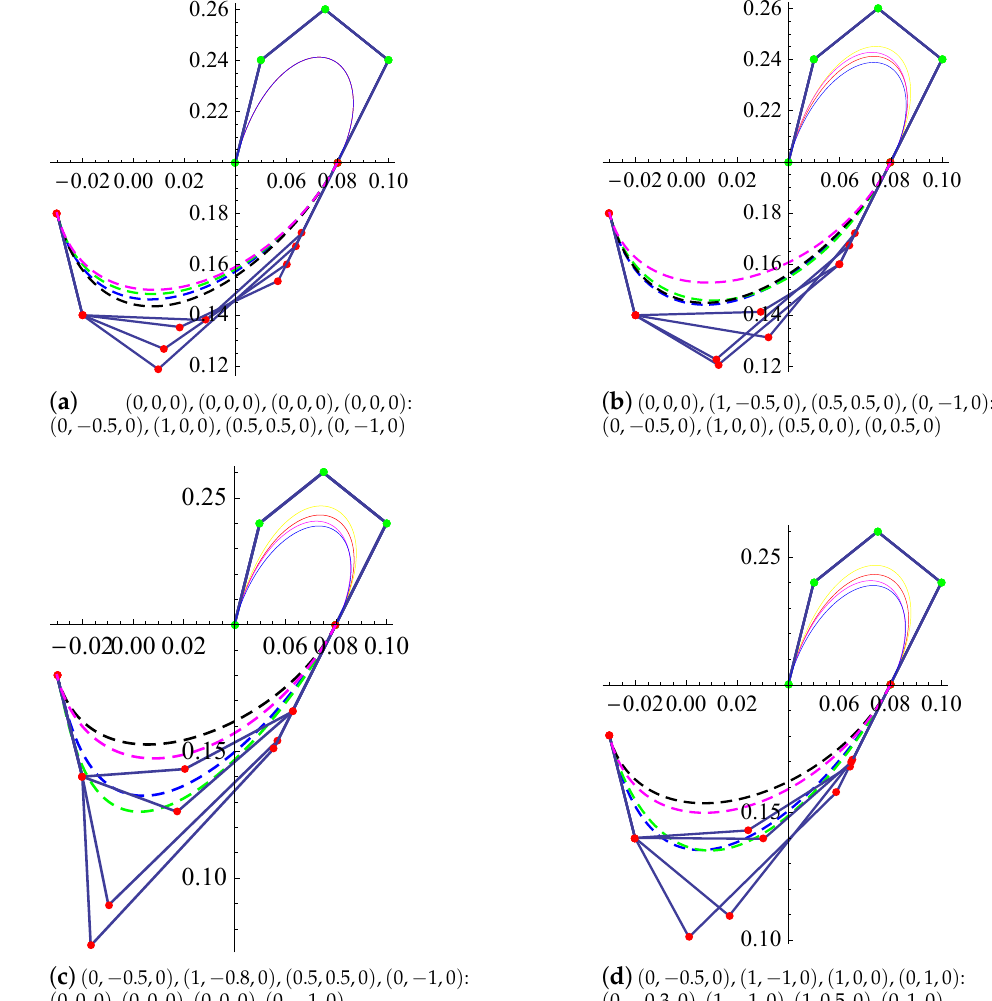
1,0 ) ; ( b ) ( 0,0,0 ) , ( 1, 0.5,0 ) , ( 0.5,0.5,0 ) , − − 0.5,0 ) , ( 1, 0.8,0 ) , ( 0.5,0.5,0 ) , ( 0, 1,0 ) : − − − 0.5,0 ) , ( 1, 1,0 ) , ( 1,0,0 ) , ( 0,1,0 ) : ( 0, 0.3,0 ) , − − −